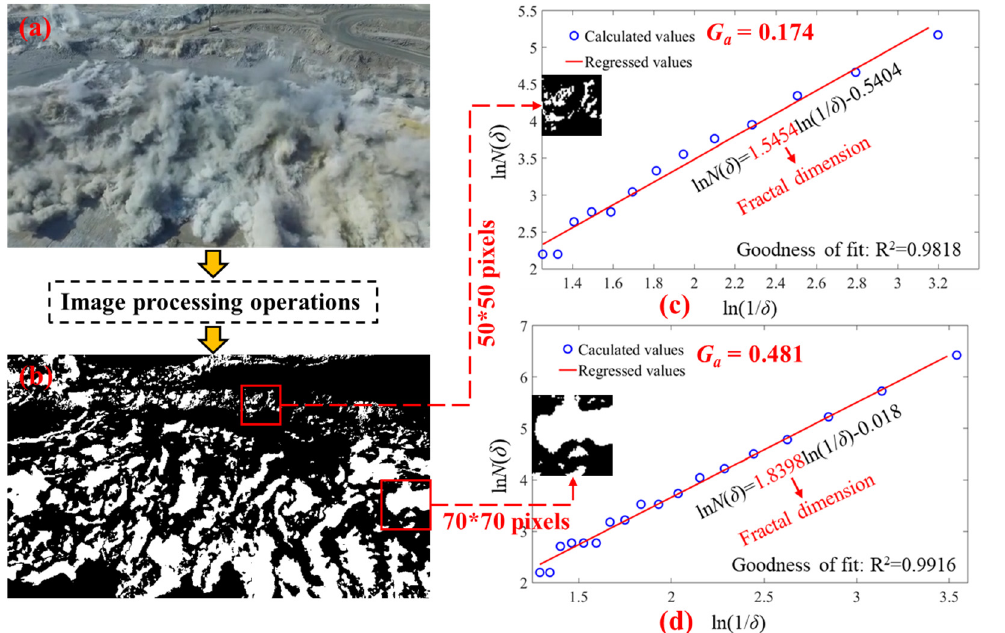
Figure 10. Calculation results of D box (P) and G a of two single-point pollution areas in the 30th image, including ( a ) original image selected at 30 s from the recorded video, ( b ) binary image through a series of image processing operations as described previously, and ( c , d ) D box (P) and G a of the pollutants in the selected areas. Table 6. Threshold values of T 1 and T 2 with the time nodes of image